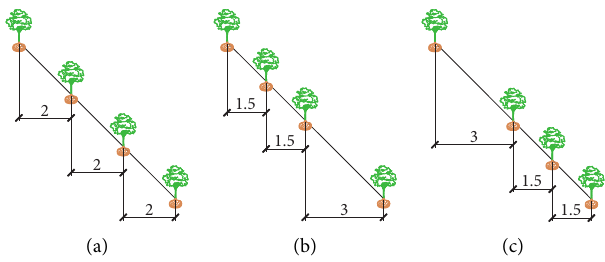
Figure 7: Schematic diagram of the tree planting pattern (unit: m). Table 4: Orthogonal test results of the slope safety factor.